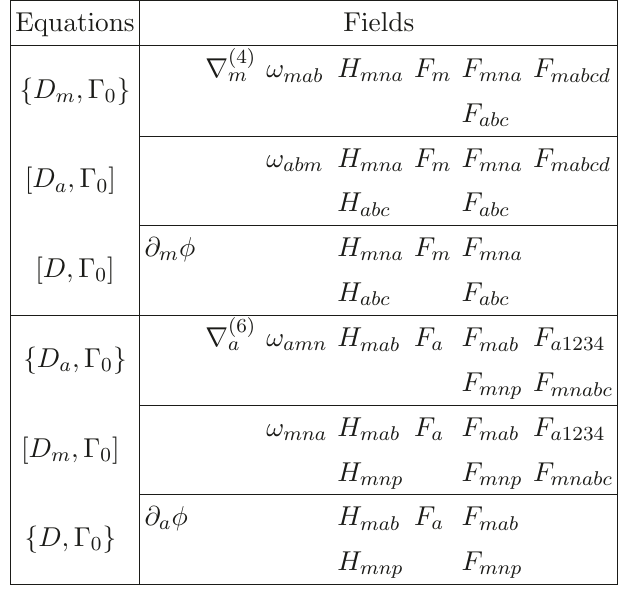
Table 1 . The string field components present in the various supersymmetry equations